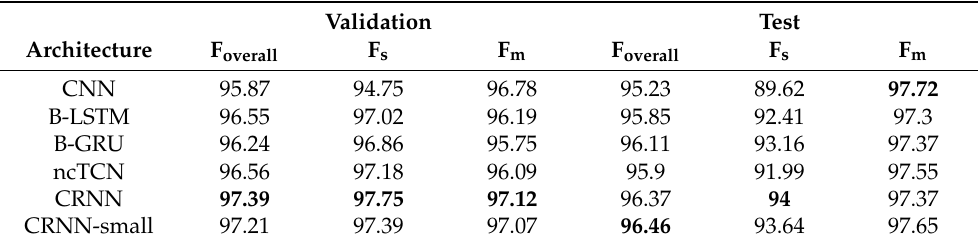
Table 3. The evaluation of different neural network architectures on the validation and test set. CRNN-small is the simplified version of the CRNN model, which has less number of filters for each convolutional layer. The bold values indicate the largest number in each